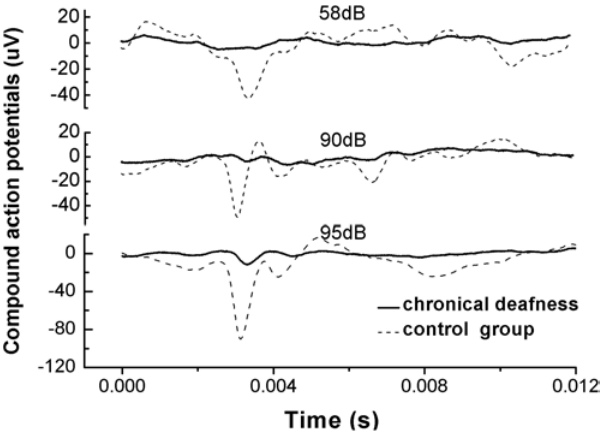
Fig. 2. ACAPs measured from a chronically deafened guinea pig (chronical deafness) and a normal guinea pig (control group). The sound pressure of short pure stimuli from bottom to top is 95, 90, 58 dB, respectively. For chronically deafened guinea pig, the hearing threshold is about 95 dB while the normal one is less than 58